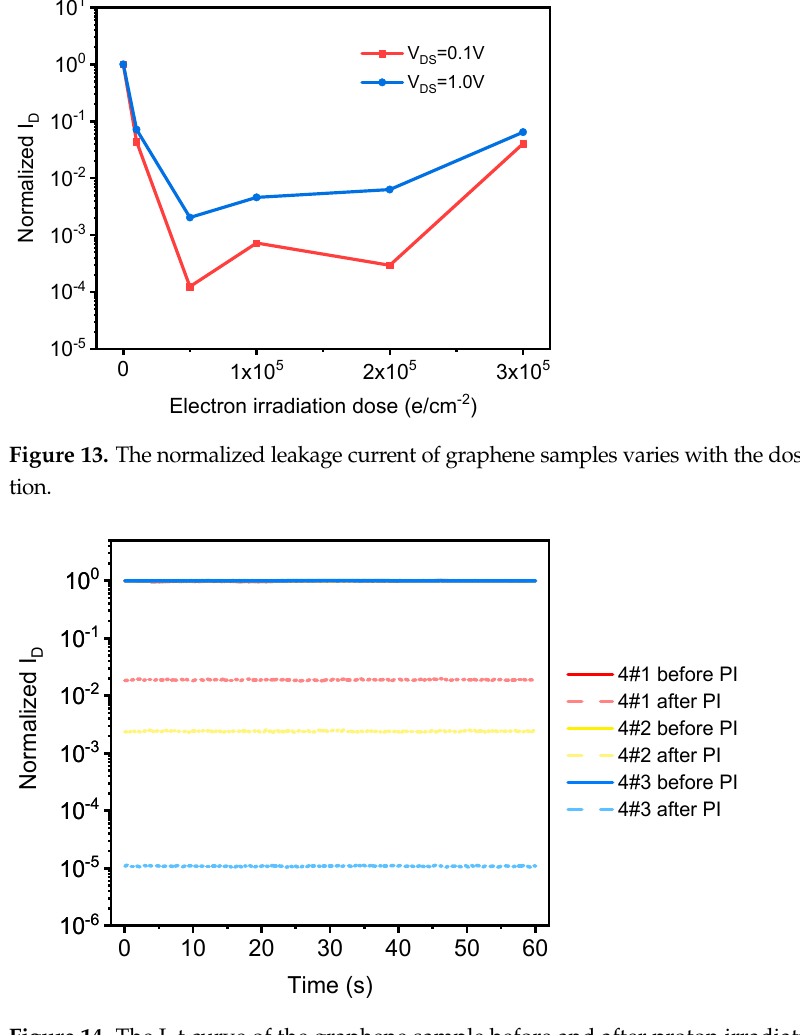
Figure 14. The I–t curve of the graphene sample before and after proton irradiation.